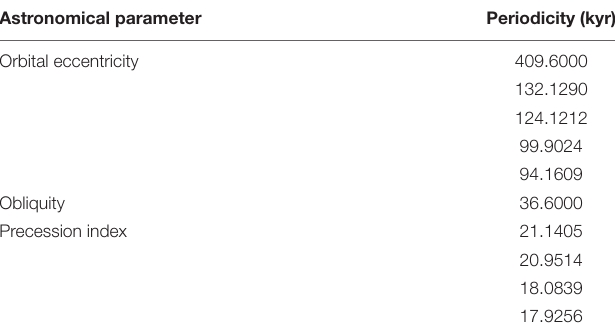
TABLE 1 | Orbital eccentricity, obliquity, and precession index periodicities from the periodogram of the La2004 astronomical solution (Laskar et al., 2004), between 129.55 and 134.55 Ma, i.e., a 5 Myr-long interval with a median age 132.05 Ma, calculated by Acycle for the TimeOpt astronomical target (orbital eccentricity and precession index) and for the ASM and COCO astronomical frequency targets (all three astronomical